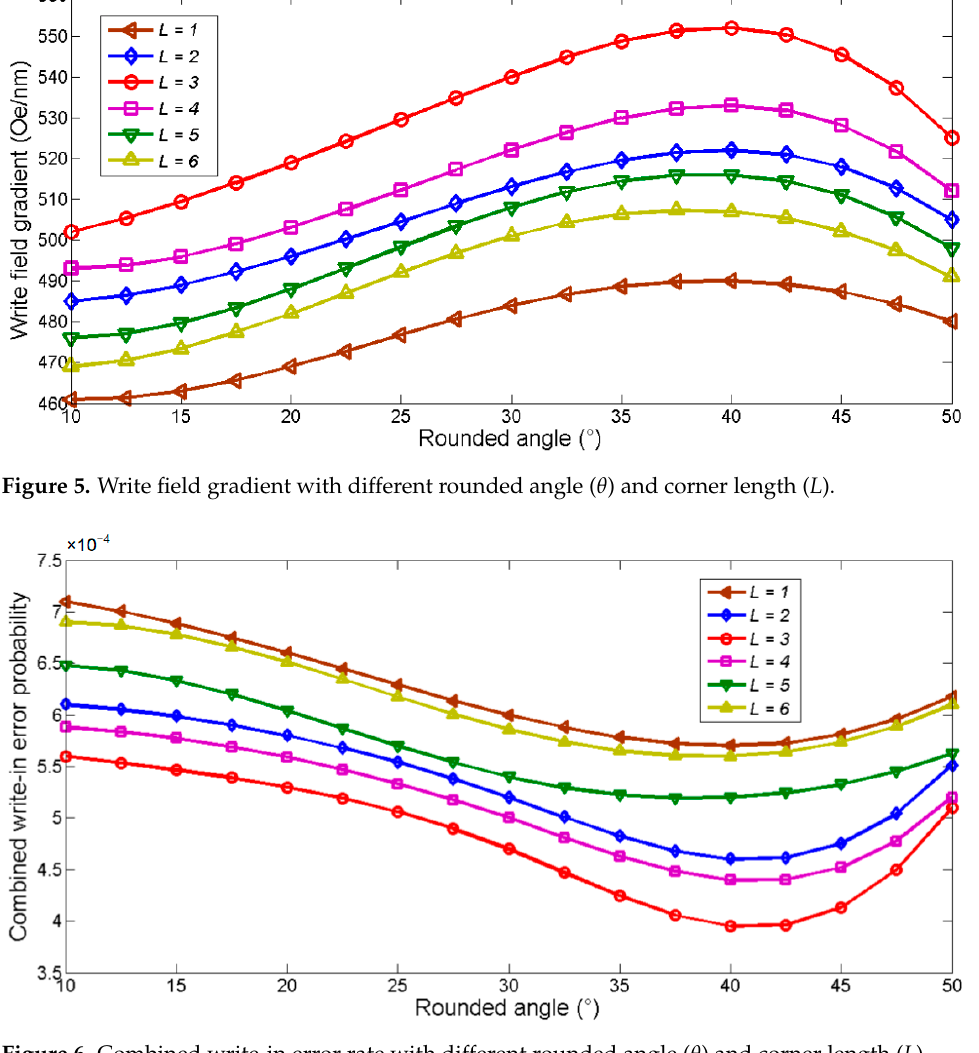
Figure 5. Write field gradient with different rounded angle ( θ ) and corner length ( L ).